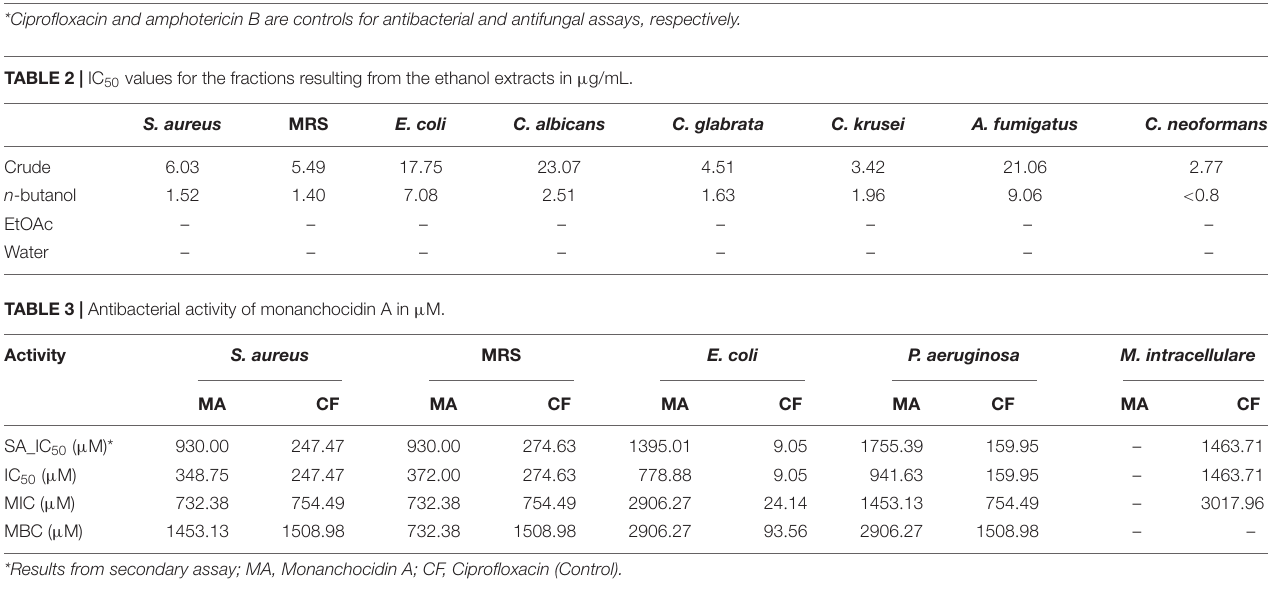
TABLE 4 | Antifungal activity of monanchocidin A in µ M.